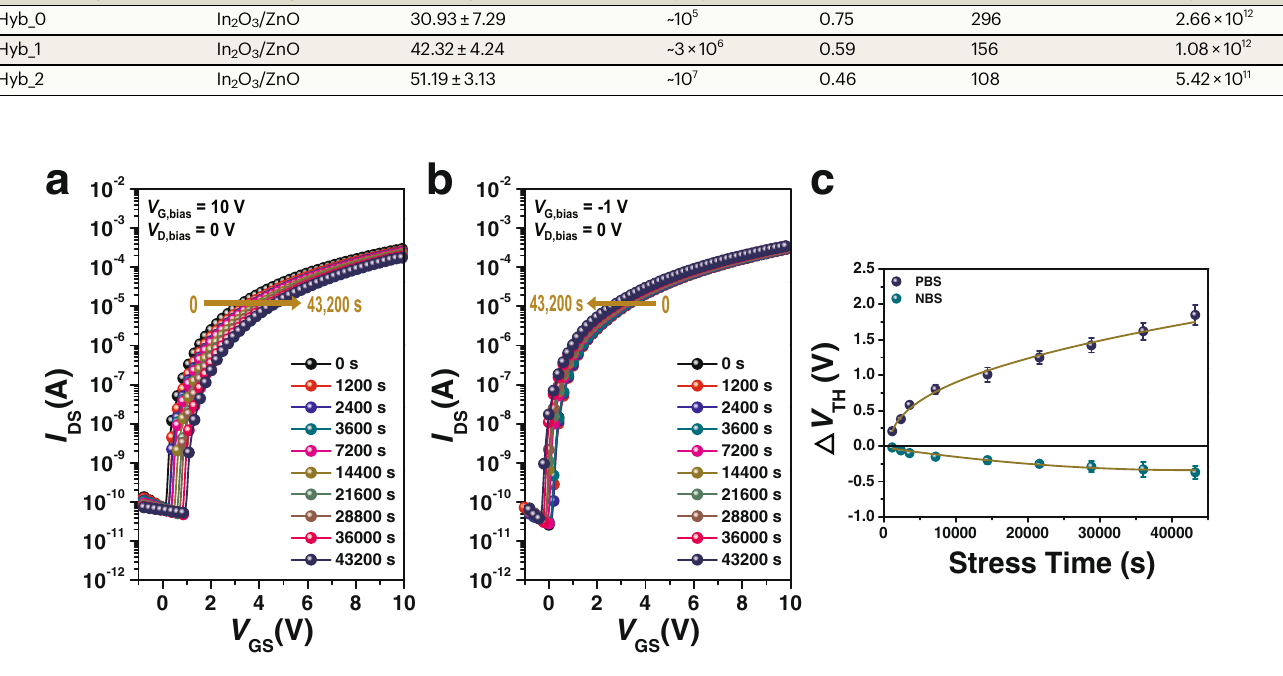
bias-stress time varied between 0 and 43,200s. c Time dependence of △ V TH as a function of stress time under PBS and NBS conditions. Error bars represent the V − 1V, V standard deviation from 10 devices. G,bias = D,bias =0V). The